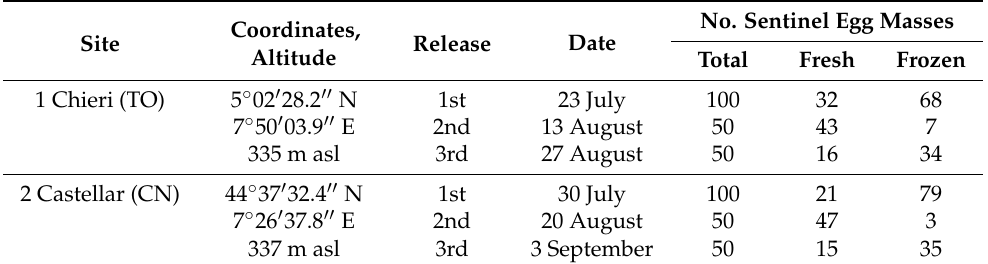
Table 1. Numbers of Halyomorpha halys sentinel egg masses (fresh and frozen) exposed after each release of Trissolcus kozlovi adults in the two hazelnut orchards in Piedmont, North Italy, in 2018. No. Sentinel Egg Masses Coordinates, Site Release Date Altitude Total Fresh